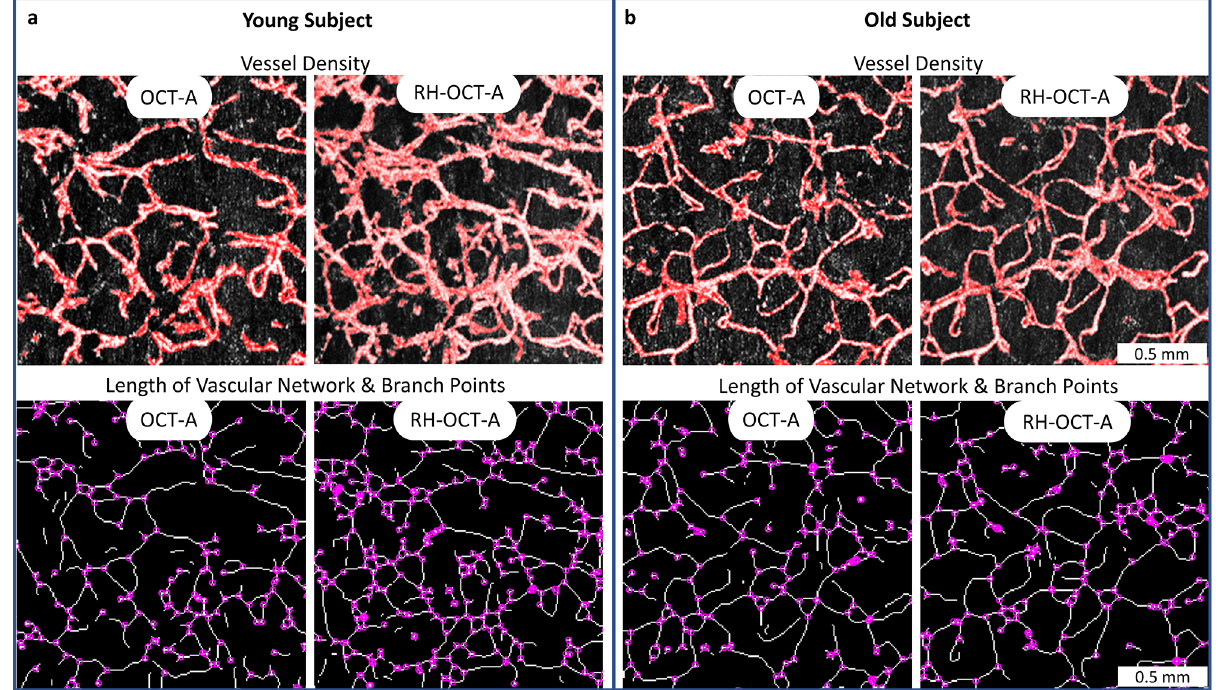
Figure 2. Imaging of human dermal microvasculature. ( a ) Baseline perfusion (OCT-A) images and reactive hyperemia (RH-OCT-A) images showing the vessel density (VD, red colored overlay) of a representative young (age: 25 years; systolic blood pressure: 117 mmHg) and ( b ) old subject (age: 66 years; systolic blood pressure: 136 mmHg). The skeleton maps of the vessel network (1-pixel trace width) show the length of the vascular network (LVN, white pixel) and number of vessel branch points (NBP, purple